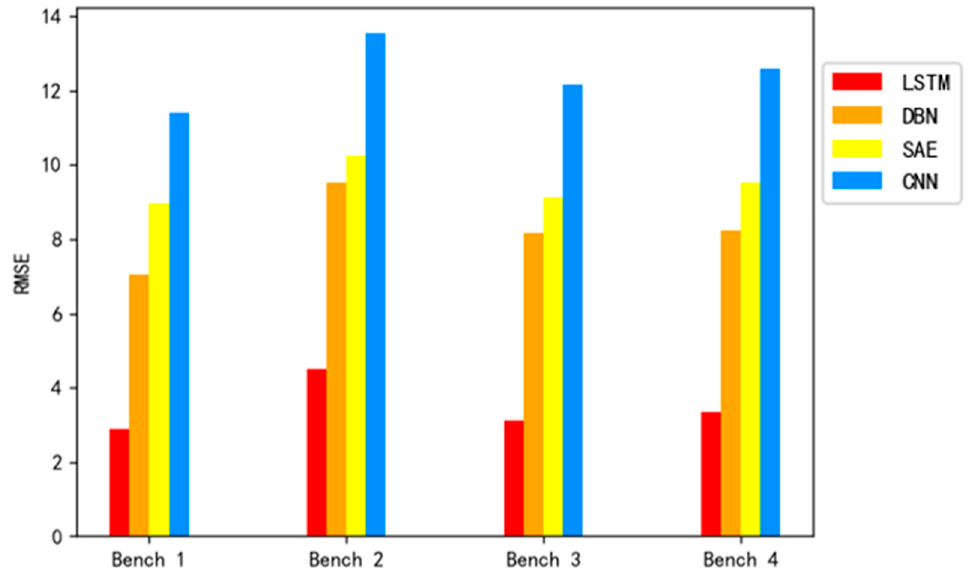
Figure 10. RMSE comparison under different methods. Table 5. Details of the four bench